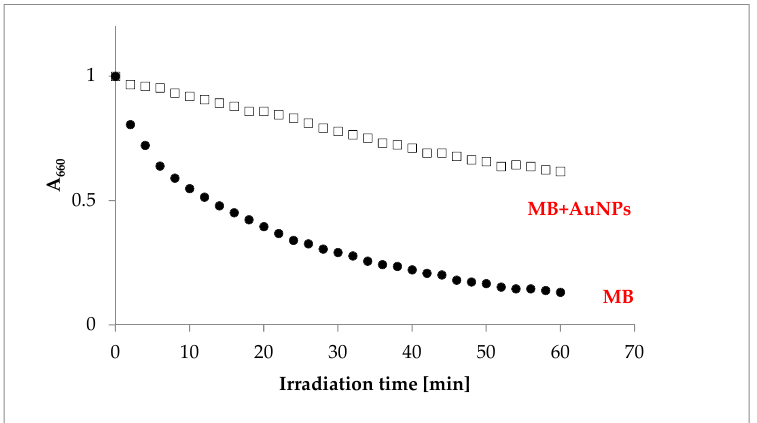
Figure 6. Kinetic curves of MB photobleaching in the absence ( ● ) or presence ( □ ) of AuNPs. As can be clearly seen from Figure 6, the change of the concentration of the MB upon photobleaching of the MB without gold nanoparticles was much faster than the photo- bleaching of the mixture of MB with the gold nanoparticles. The process of photofading was less effective in the MB + AuNPs system than in the solution of MB, thus enhancing the effectiveness of the singlet oxygen production in the mixture, in comparison to the MB alone. 3. Discussion Under the conditions defined in our studies we found that antimicrobial PDT in vitro reduces the concentration of Staphylococcus aureus and Escherichia coli viable cells, and that this process is enhanced by biogenic gold nanoparticles. Methylene blue was chosen as the photosensitizer because it is a well-known pheno- thiazine dye used in medicine as a therapeutic agent [21] or a photosensitizing compound [22]. This molecule is of particular interest for use in PDT due to its physicochemical prop- erties. MB exhibits a quantum yield of singlet oxygen formation of about 0.5, with low reduction potential, and intense light absorption between 550 nm and 700 nm in water (in the phototherapeutic window). It is well known that MB is a highly hydrophobic com- pound, with a higher chemical affinity to nucleic acids, and showing low levels of toxicity in mammalian cells [25]. Currently, MB is used by several European agencies for the dis- infection of blood plasma, due to its effectiveness in the photodynamic inactivation of microorganisms, such as bacteria [26], and viruses [27], including HIV, and hepatitis B and C [28–31]. In addition, an important point to consider is the much lower cost of treat- ment based on this dye, compared to other available photosensitizers. It was previously shown that MB has a significant antimicrobial effect in the dark, and that this activity can be increased in the presence of oxygen by applying light with a wavelength corresponding to its electronic absorption band [30]. Therefore, it was reason- able to study the dark bactericidal activity of this dye. From the results collected in Table 2, it follows that the reduction in number of S. aureus cells was insignificant up to a MB concentration of 12.5 mgL − 1 . In the case of E. coli, insignificant reductions in the number of cells were observed up to a concentration of 100 mgL − 1 of MB. These observations show that the dark toxicity of MB depends on the type of bacteria: Gram-positive coccus was more sensitive to MB than Gram-negative rods. These findings are consistent with the results obtained by Usacheva et al. [32], who hypothesized that this is due to the presence of an outer membrane in Gram-negative bacteria. The detailed analysis of the results seen in Figures 2–4 indicates that, regardless of the radiation power density used, the biogenic gold nanoparticles synthesized by M.